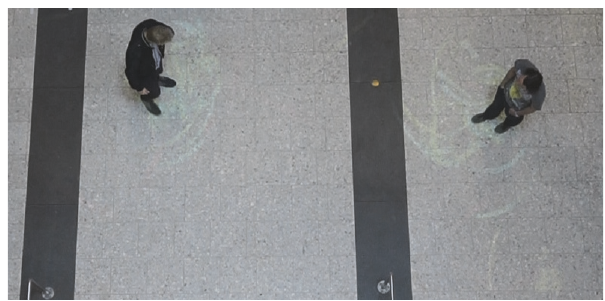
Figure 6: Players interacting with the Light Trails